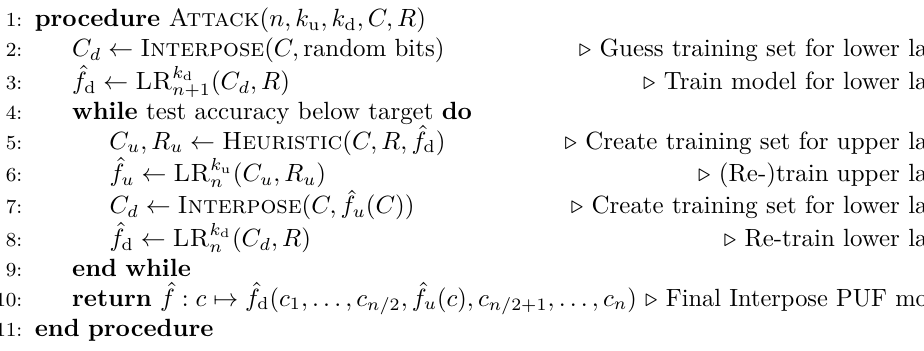
Algorithm 2 Divide-and-Conquer Interpose PUF